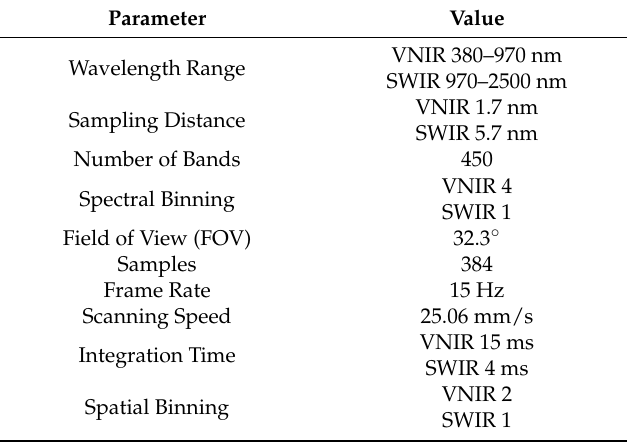
Table 1. Specifications and setup parameters of the SisuROCK drill-core scanner and AisaFENIX VNIR-SWIR hyperspectral sensor.